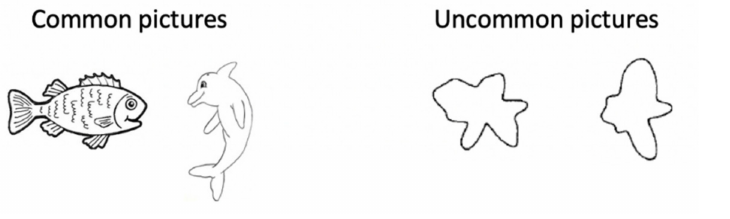
Figure A1. Sample